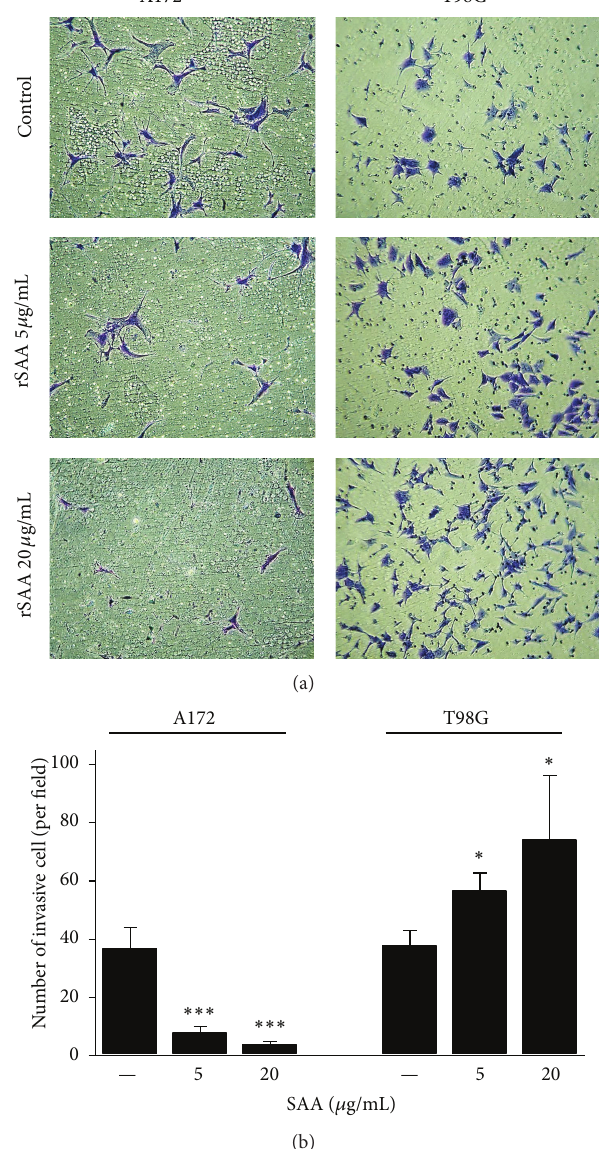
Figure 3: rSAA (5 and 20 𝜇 g/mL) affects invasion of human glioma cell lines. (a) The invasion of A172 cells decreased in the matrigel in thepresenceofrSAAwhiletheinvasionofT98Gcellsincreasedafter 48 h. Photos are representative of three independent experiments. (b) Quantitative representation. ∗ 𝑃 < 0.05 , ∗∗∗ 𝑃 < 0.001 versus